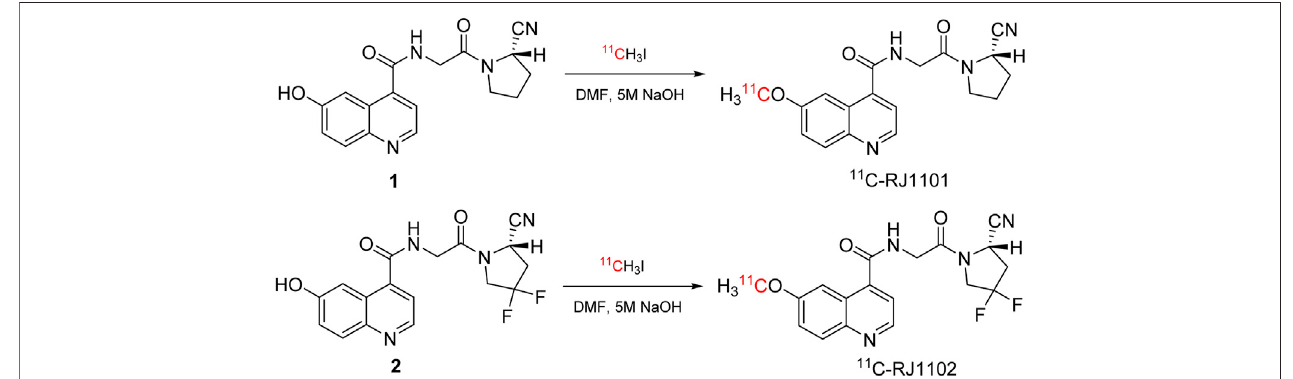
FIGURE 1 | The radiolabeling of 11 C-RJ1101 and 11